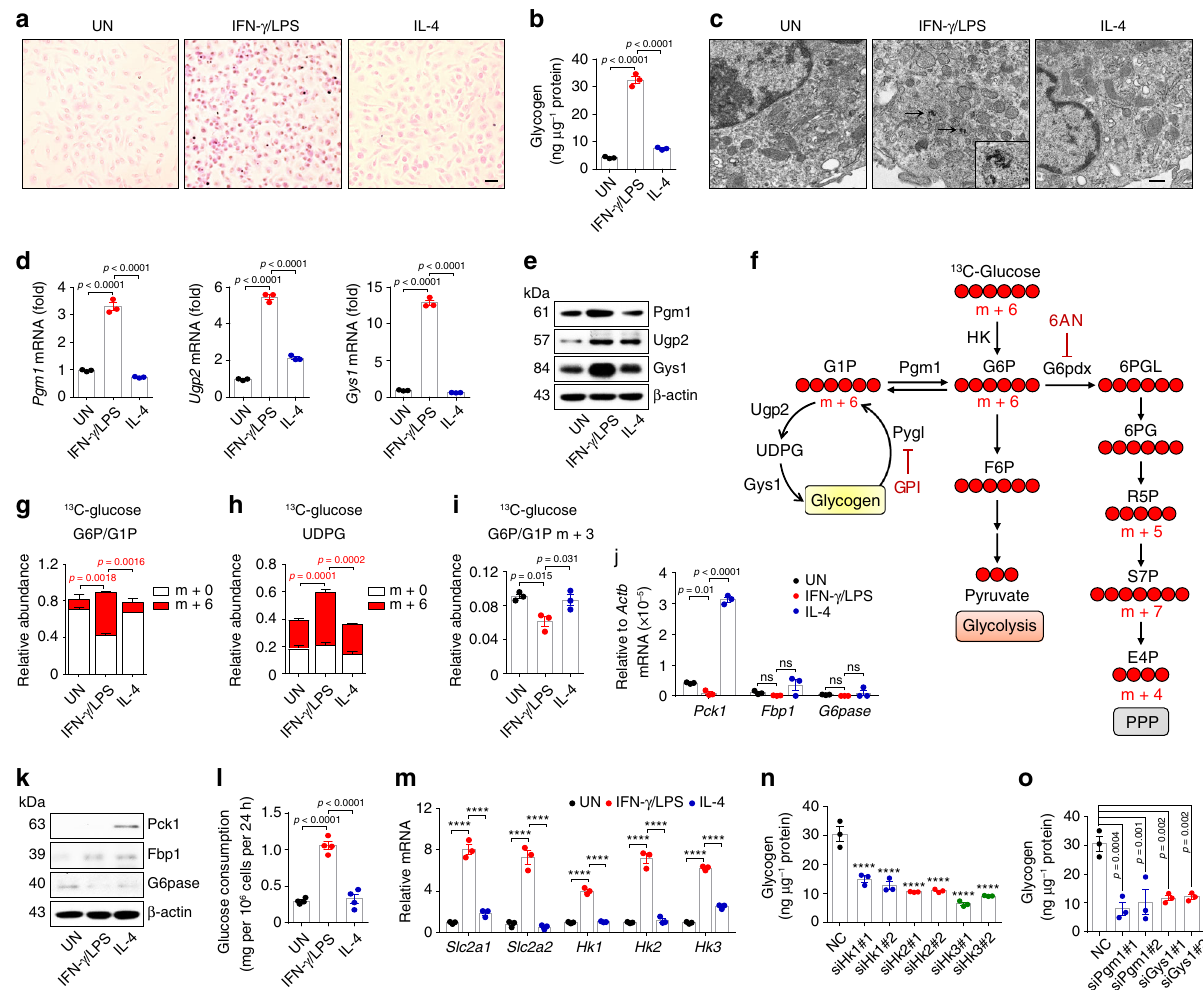
Fig. 1 Glycogen is synthesized in in fl ammatory macrophages. a – c Intracellular glycogen levels in untreated, IFN- γ /LPS (20ngmL − 1 IFN- γ plus 100ngmL − 1 LPS) or IL-4 (10 ng mL − 1 ) treated BMDMs were detected and observed by PAS staining (scale bar, 20 μ m) ( a ), colorimetric assay ( b ) and TEM (scale bar, 0.5 μ m) ( c ). The arrows point to intracellular glycogen deposits. d , e Pgm1, Ugp2, and Gys1 expression in untreated, IFN- γ /LPS or IL-4 treated BMDMs were determined by real-time PCR ( d ) and western blot ( e ). f Overview of three glucose metabolic pathways: glycogen metabolism (left), glycolysis (middle) and PPP (right) and the inhibitors (GPI/6AN) are shown. g – i BMDMs differentiated in normal 12 C-glucose were stimulated with IFN- γ /LPS or IL-4 for 6 h and switched to 13 C-glucose for 6 h, LC-MS/MS was performed for m + 6-labeled G6P/G1P ( g ), m + 6-labeled UDPG ( h ) and m + 3-labeled G6P/ G1P ( i ). j , k Pck1, Fbp1, and G6pase expression in untreated, IFN- γ /LPS or IL-4 treated BMDMs were determined by real-time PCR ( j ) and western blot ( k ). l Consumption of glucose in untreated, IFN- γ /LPS or IL-4 treated BMDMs were measured by enzymatic methods. m Relative mRNA expression of Slc2a1/2 and Hk1/2/3 in untreated, IFN- γ /LPS or IL-4 treated BMDMs were determined by real-time PCR. n , o Hk1/2/3 , Pgm1 or Gys1 siRNA transfected BMDMs were stimulated with IFN- γ /LPS for 36 h. Intracellular glycogen levels were detected by colorimetric assay. Unless otherwise speci fi ed, n = 3 biologically independent experiments were performed. Data are presented as mean ± SEM. P values were calculated using one-way ANOVA, **** p <